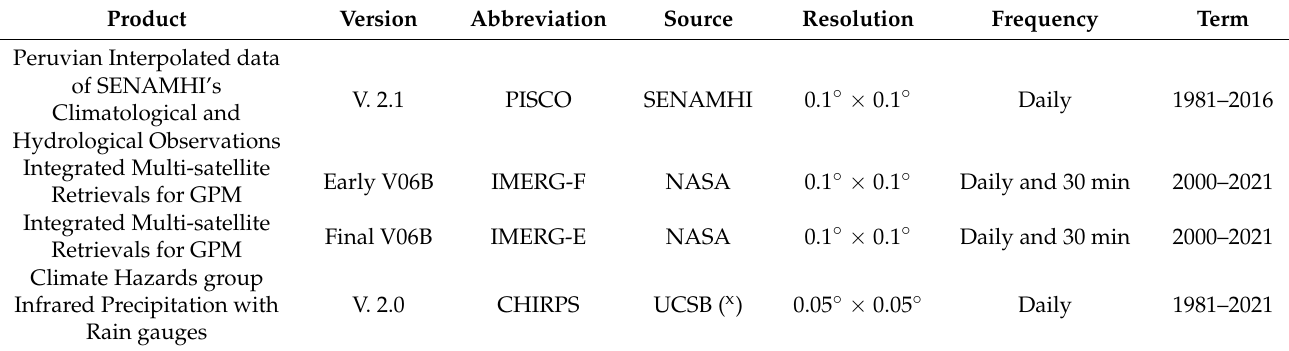
Table 3. Satellite and data base products analyzed.